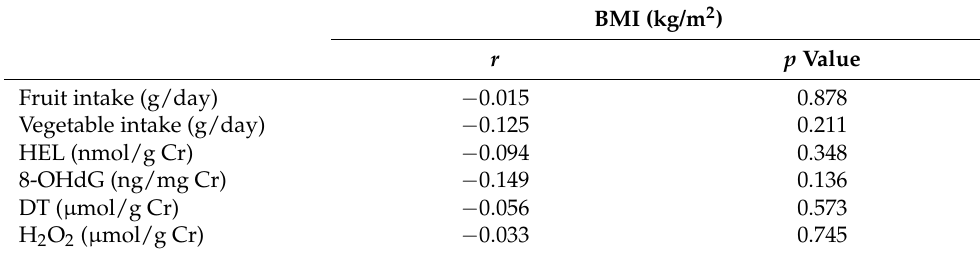
Table 5. The relationship between BMI with the urinary biomarkers and fruit/vegetable intake. BMI (kg/m 2 ) r p Value Fruit intake (g/day) − 0.015 0.878 Vegetable intake (g/day) −